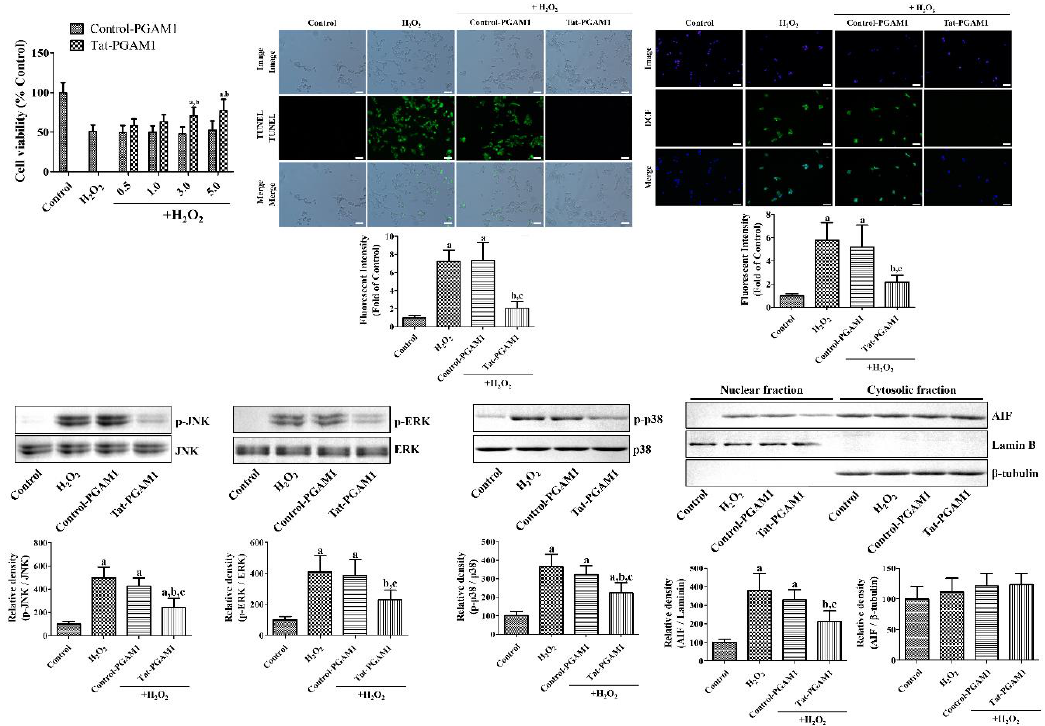
Figure 2. The protective effects of Tat-PGAM1 and Control-PGAM1 against oxidative damage in NSC34 cells. Oxidative stress was induced by treatment with 1 mM H 2 O 2 for 3 h (terminal deoxynucleotidyl transferase-mediated biotinylated deoxyuridine triphosphate (dUTP) nick end labeling (TUNEL) staining), 5 h (water-soluble tetrazolium salt-1 (WST-1) assay), 10 min (2,7-dichlorofluorescein (DCF) fluorescence), or 6 h (western blot). The cells were incubated with Tat-PGAM1 and Control-PGAM1 (both 3 μM for TUNEL and DCF staining) for 60 min before treatment with 1 mM H 2 O 2 and measured with each assay kit. The cell viability, DNA fragmentation, and reactive oxygen species (ROS) formation were measured using a WST-1 assay, TUNEL staining, and DCF fluorescence, respectively. Scale bar = 50 μm. Mitogen-activated protein kinase (MAPK) pathways were confirmed by western blot analysis for c-jun N-terminal kinase (JNK), extracellular-signal-regulated kinase (ERK), p38, and their phosphorylated antibodies. In addition, apoptosis inducing factor (AIF) levels were measured in nuclear and cytosolic fraction. The cell viability was measured and the data were analyzed using two-way ANOVA followed by Bonferroni’s post hoc test ( a p < 0.05, significantly different from the control group; and b p < 0.05, significantly different from the Control-PGAM1 group). The intensities of TUNEL positive cells, the DCF fluorescence, and the optical densities of the protein bands were measured and the data were analyzed using one-way ANOVA followed by Bonferroni’s post hoc test ( a p < 0.05, significantly different from the control group; b p < 0.05, significantly different from the only H 2 O 2 group; and c p < 0.05, significantly different from the Control-PGAM1 group). The bar graph represents the mean ± standard deviation (SD).